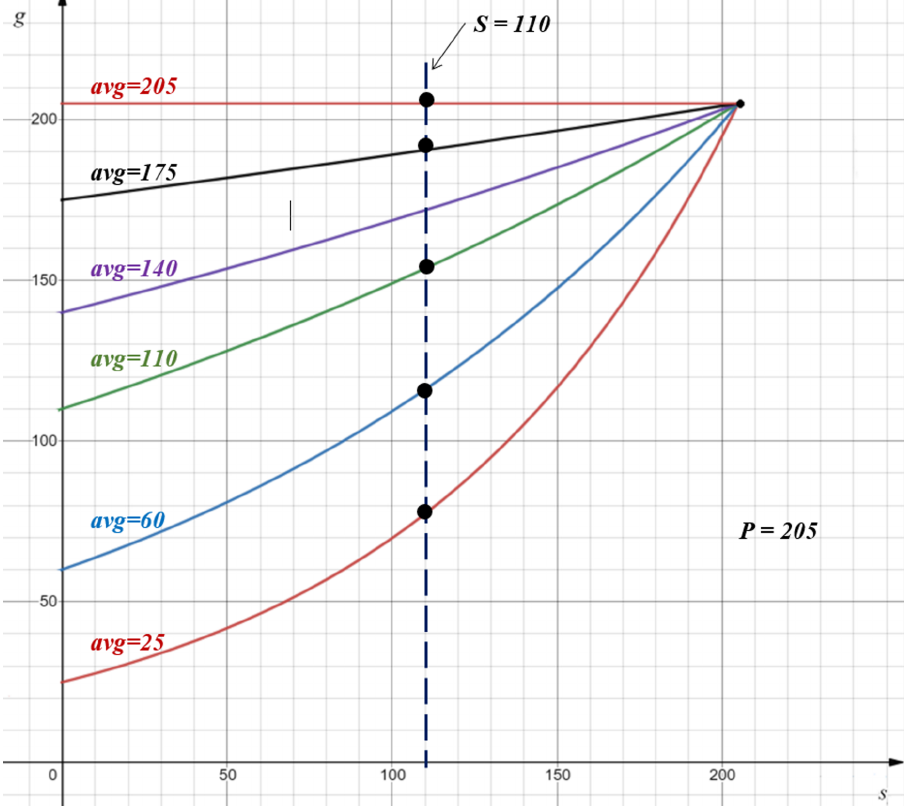
Figure 5. Data range of the pooled value. This plotted chart illustrates the relationship among s , p , and g in Equation (2). It lists 6 cases (curves) of average values (25, 60, 110, 140, 175, and 205). Assume that the regular max pooled value p is 205 and the max pooled on the weight map s is 110. The black dots are the output g of our pooling method, which are between the corresponding averages and the regular max one